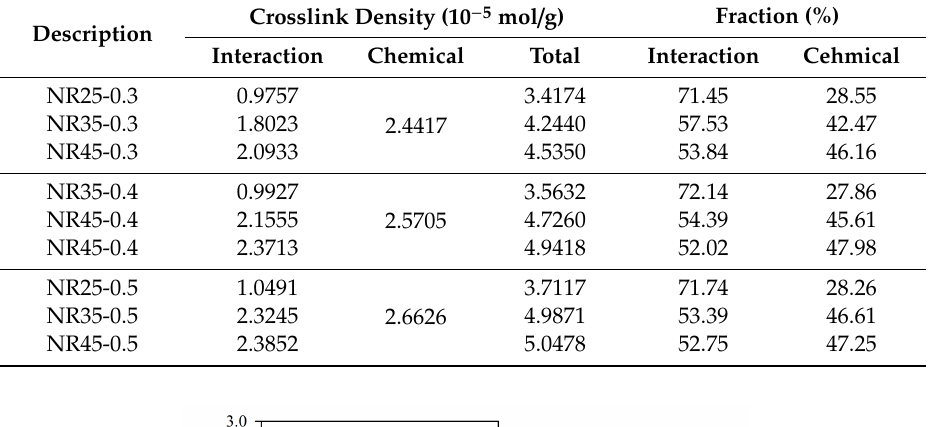
Figure 3. Fraction of the chemical crosslink density and rubber–filler interaction in the NR samples with varying accelerator and carbon black content. Table 5. Calculated density of the chemical crosslink and rubber–filler interaction in the NR samples with varying accelerator and carbon black content.